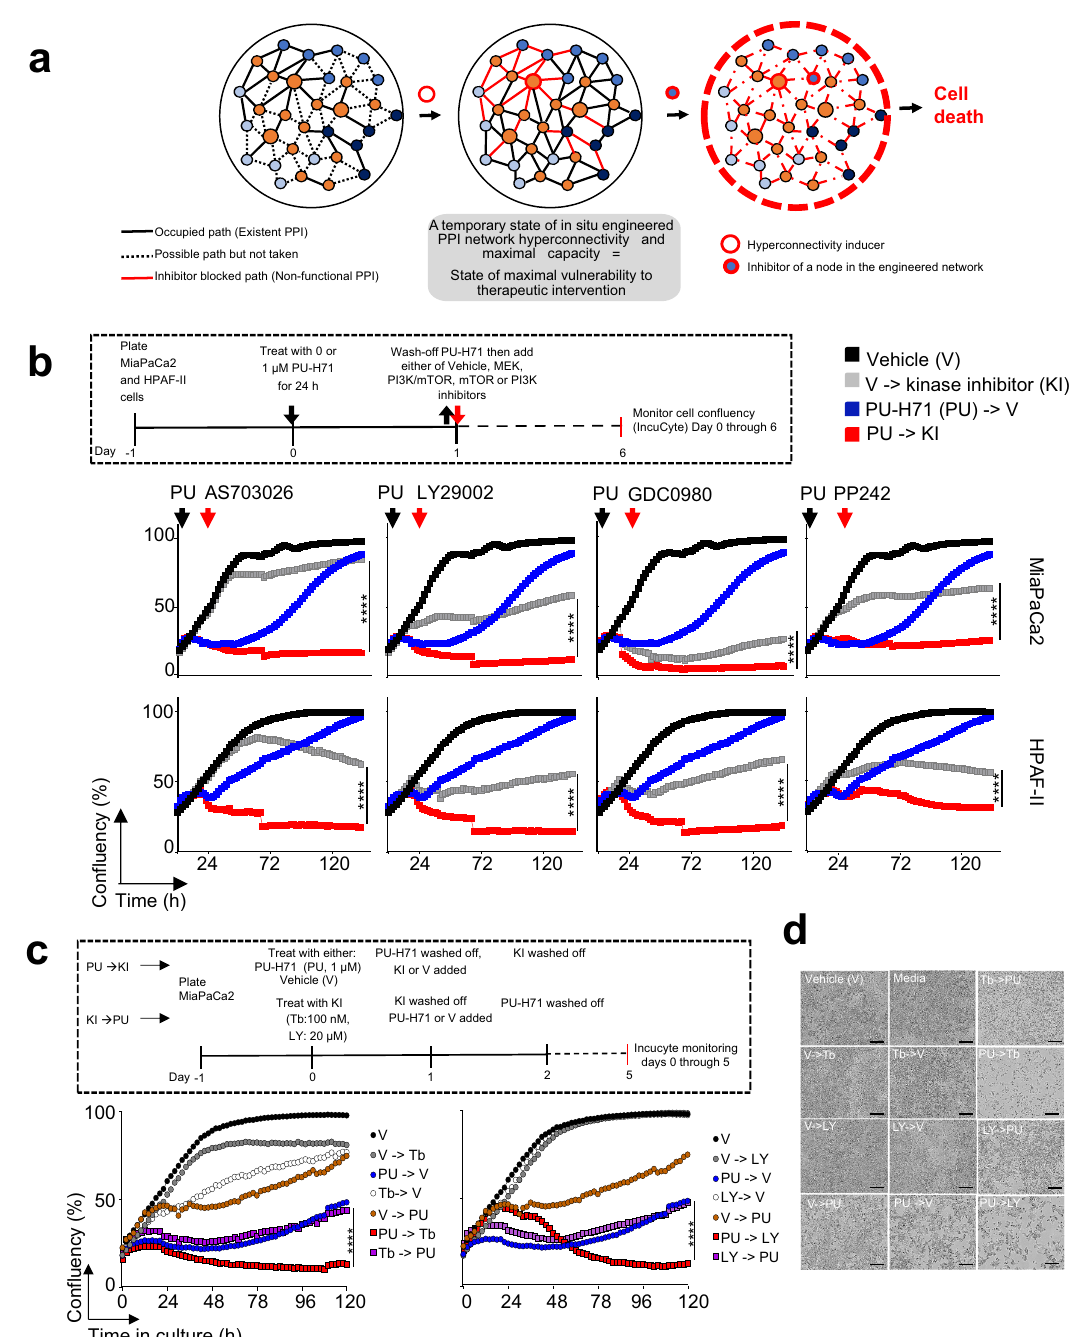
Fig. 6 Current drugs are more effective than previously observed if controllability measures are exercised in tandem with drug treatment whereby cancerous cells are forced into a state of interactome hyperconnectivity. a Schematic of the pharmacologically enforced,